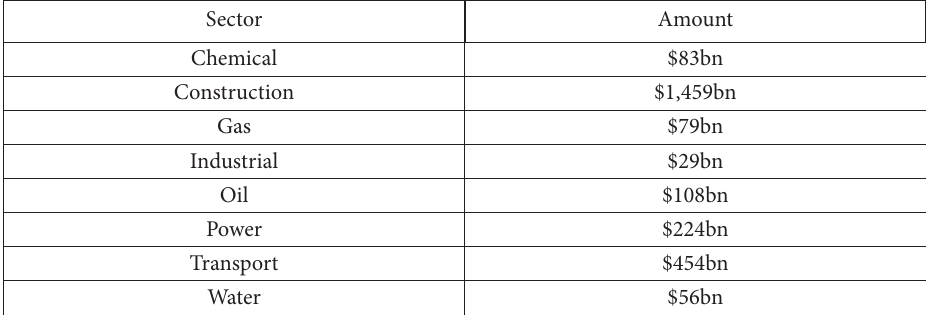
Table 7. Value of planned, unawarded GCC projects by sector/ $2tn project pipeline (source: MEED Projects, GCC Projects, Break bulk Middle East, 2018a)